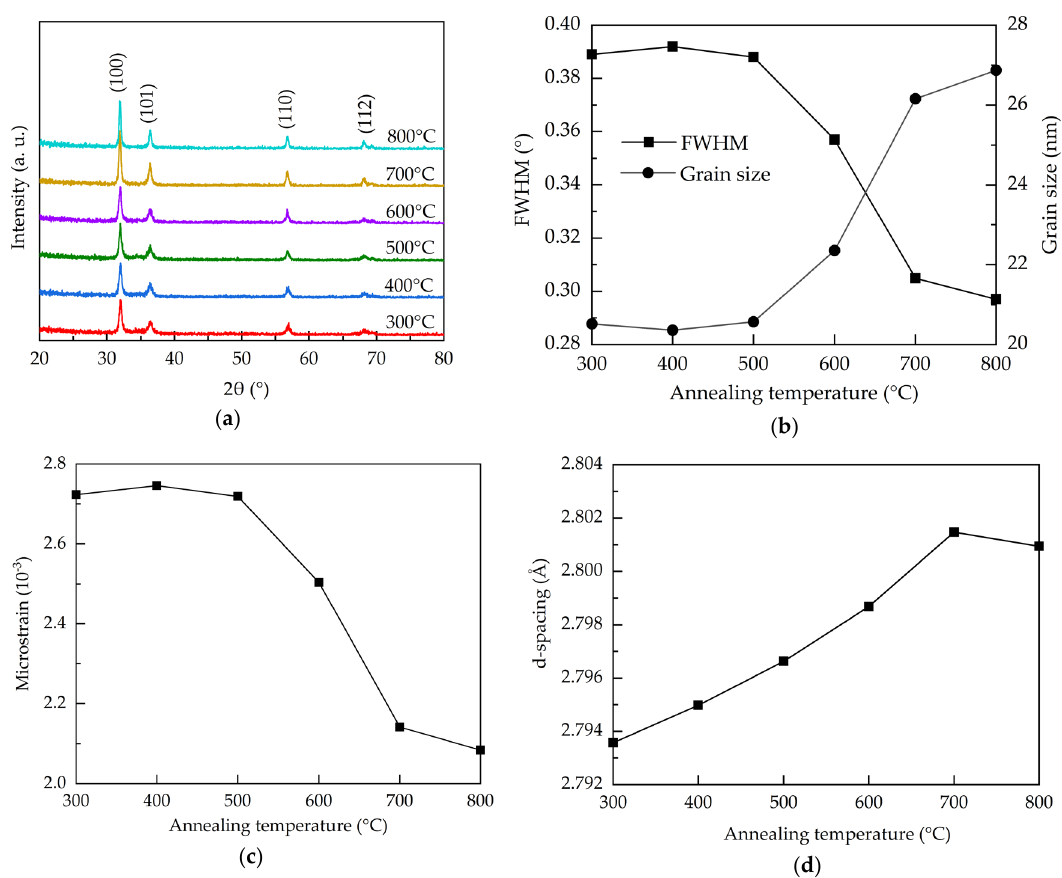
Figure 2. ( a ) XRD patterns, ( b ) FWHM and grain size, ( c ) microstrain, and ( d ) d-spacing of the AALD Al:ZnO thin films annealed at different temperature.